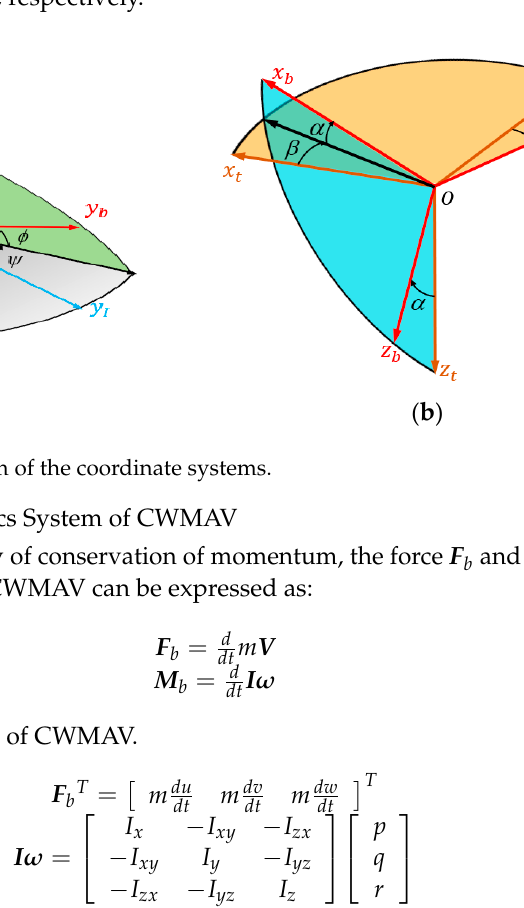
Figure 1. Schematic diagram of the proposed modeling framework.